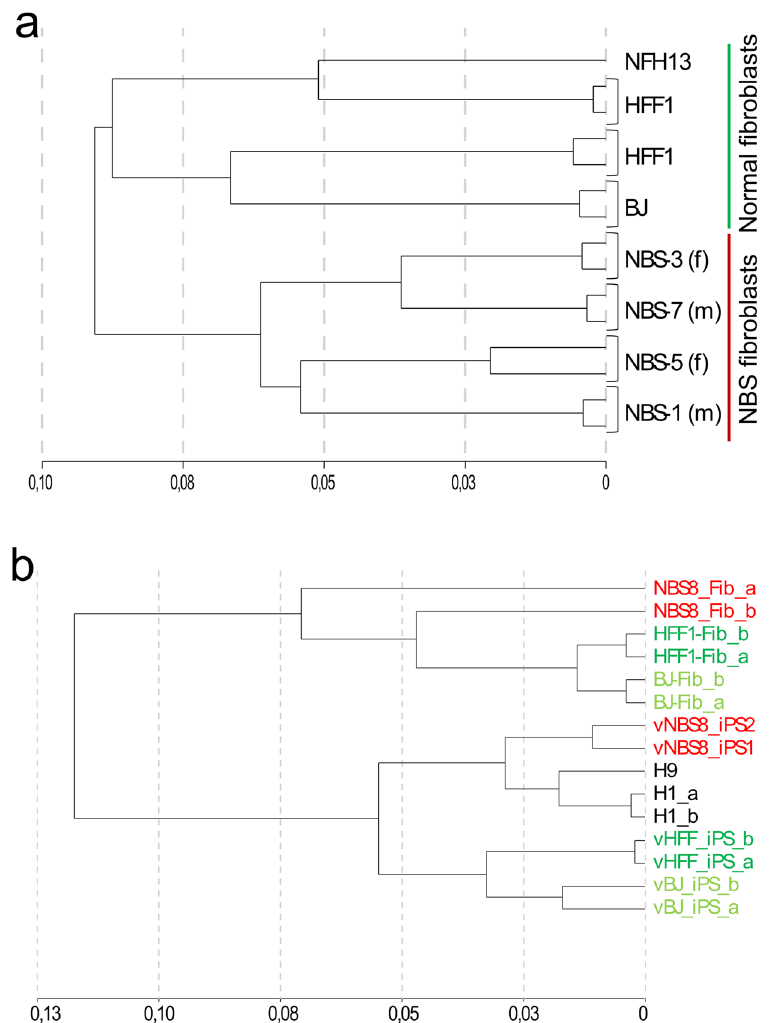
Figure 2. Global transcriptomic comparison of NBS fibroblasts and iPSCs to healthy controls. ( a ) Hierarchical cluster analysis depicting the distance of control (BJ, HFF1, NFH13) and patient (NBS-1, -3, -5, -7) fibroblasts global mRNA (Illumina 8-chip). ( b ) Hierarchical cluster analysis of total mRNA depicting the distance of control (BJ-Fib, HFF1-Fib) and patient (NBS8-Fib, passage number 8 and 15) fibroblasts, plus control (H1, H9, vHFF-iPS, vBJ-iPS) and patient (vNBS8-iPS, clone 1 and 2) pluripotent stem cells (Illumina